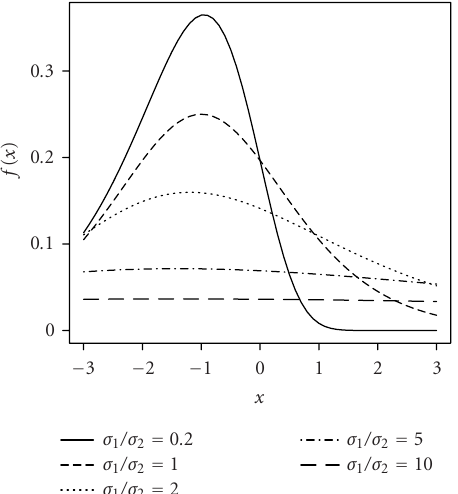
Figure 2.1. The generalized logistic pdf (2.3) for σ 1 /σ 2 = 0 . 2,1,2,5,10, σ 2 = 1, µ 1 = 0, and µ 2 = 1.